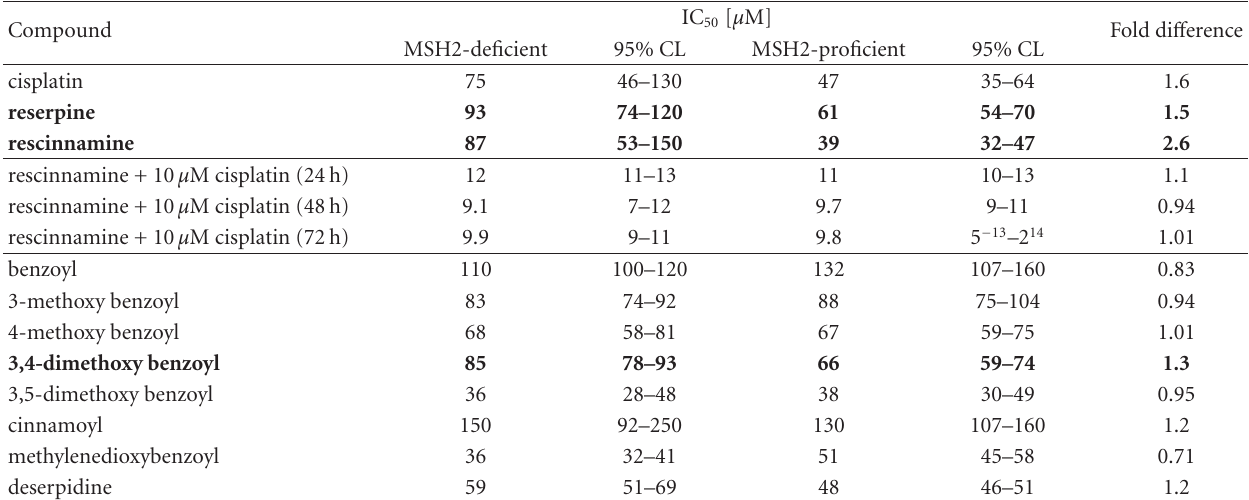
Table 1: IC 50 values for response of MSH2-deficient and MSH2-proficient cells to Reserpine analogs.